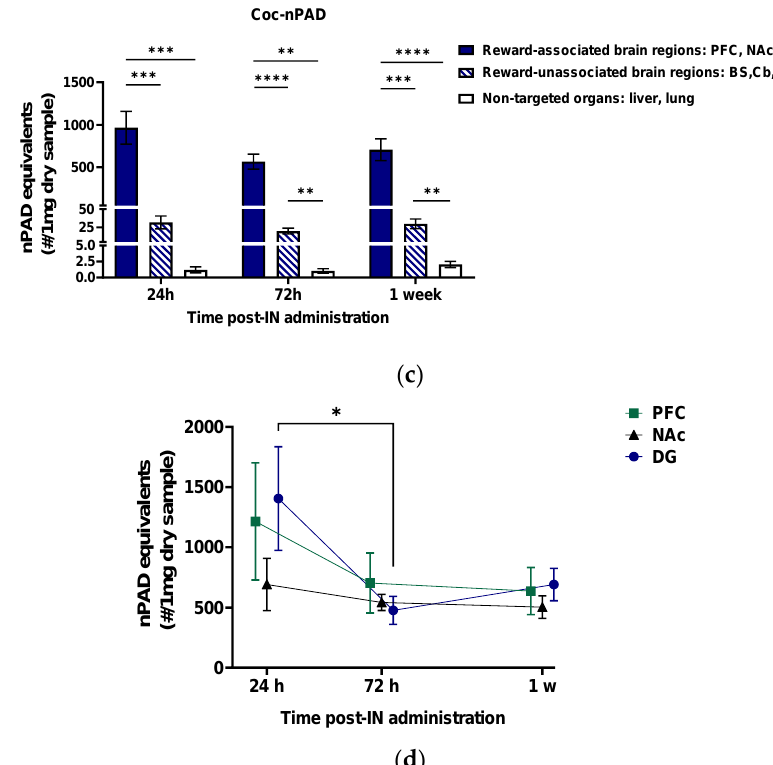
Figure 2. PLX-PAD navigation in the brain. ( a ) Experimental design. Rats underwent self-administration training with cocaine or saline on Days 1–14, then IN treatment on Day 15 with gold nanoparticle (GNP)-labeled PLX-PAD (nPAD) or with free GNPs (fGNP), and extinction training on Days 16–22. At 24 h, 72 h, and/or 1 -week post-treatment (as indicated). Rats from each group underwent in vivo CT scanning followed by sacrificing and analysis of brain regions, lungs, and liver by inductively coupled plasma optical emission spectrometry (ICP-OES). nPAD equivalents were estimated from GNP number by nPAD (see GNP labeling section) and fGNP groups; ( b ) nPAD and fGNP accumulation in different brain regions 72 h post-treatment in relation to pathology. GNPs in each brain region were quantified using ICP-OES (n = 4–7 per group). Significance is shown only for within-region comparisons. Significance of nPAD number in the PFC, NAc, and DG Ventricle brain regions in Cocaine+nPAD vs. Sham+nPAD (however, except for the DG and Ventricle regions, discussed in the Results and Discussion) and Cocaine+nPAD vs. Cocaine+fGNP; ** p < 0.01, **** p < 0.0001, Tukey’s multiple comparisons test. There was no significant main effect between groups in the Cb, BS, and OB brain regions; ( c ) nPAD accumulation in reward-associated and -unassociated brain regions and peripheral organs, over time in Coc-nPAD group. A comparison between Reward-associated brain regions (PFC, NAc, and DG), Reward-unassociated brain regions (Cb, BS, and OB), and Non-targeted organs (Liver and Lungs) n = 5–7 animals per group at each time point. Significance is shown only for within-time point comparisons; within-group differences across time points were not significant; ** p < 0.01, *** p < 0.001, **** p < 0.0001, Tukey’s multiple comparisons test; ( d ) nPAD kinetics in reward-associated regions in cocaine-trained rats (Coc-nPAD). n = 5–7 per data point. A post hoc Tukey showed in the DG, but not in the PFC and NAc, a significant difference in time point 24 h vs. time point 72 h. Contrarily, time point 24 h vs. time point 1-week and time point 72 h vs. time point 1-week showed no significant main effect; * p < 0.05, Tukey’s multiple comparisons test; Overall : Data show mean ± SEM.